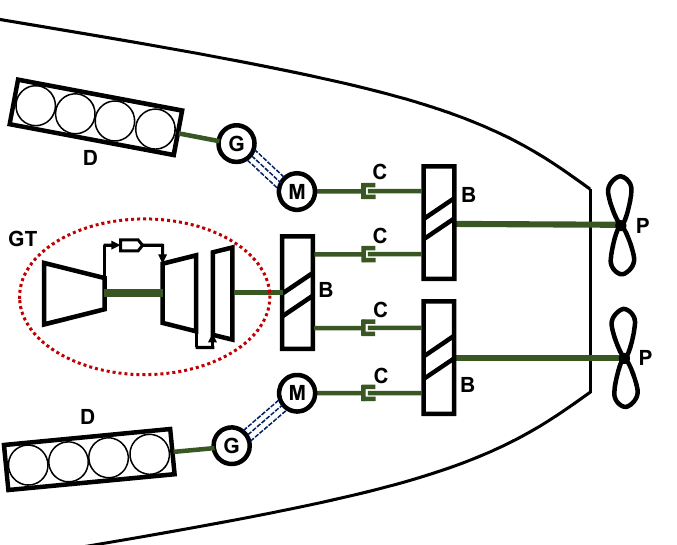
Figure 1. The scheme of CODLAG propulsion system (B-gear box, C-clutch, D-diesel engine, G-electrical generator, GT- gas turbine, M-electrical motor, P-frigate propeller).